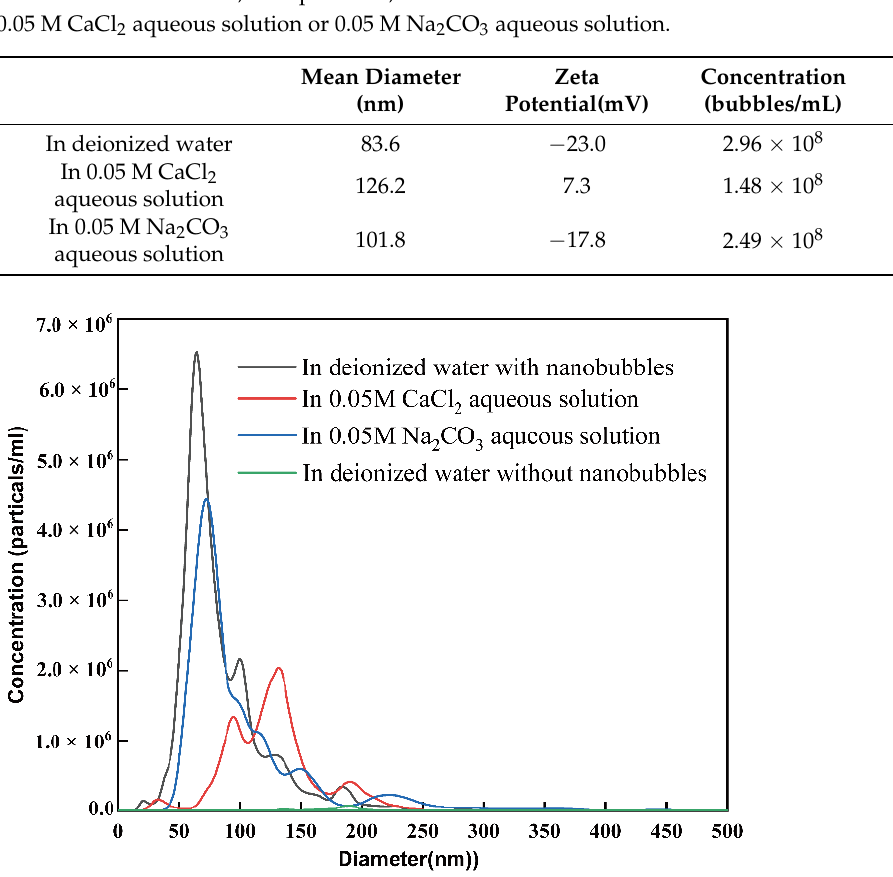
Table 1. Mean diameter, zeta potential, and concentration of nanobubbles in deionized water, in